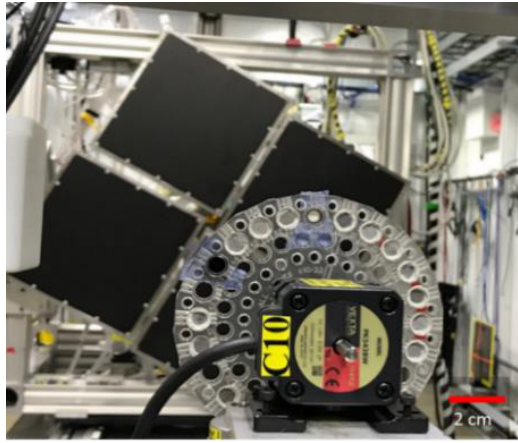
Figure 2. Wheel sample fixture used to hold and index samples during SAXS experiment.